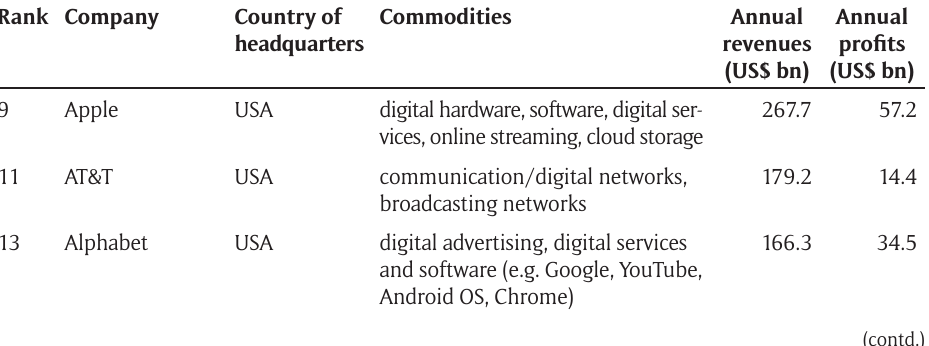
Table 1: The dominant transnational communication and digital corporations. Rank